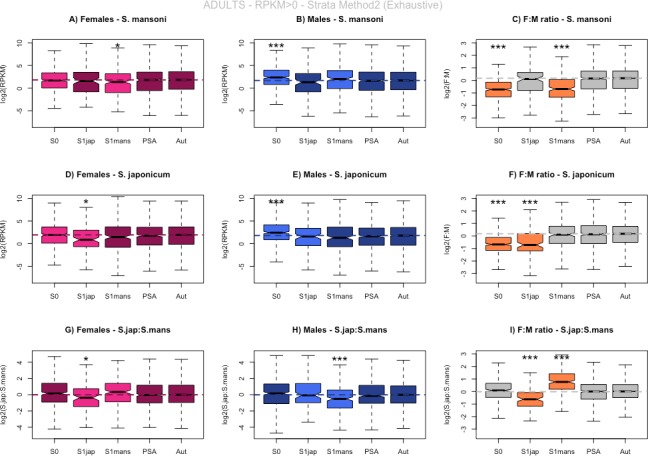
Adult expression patterns (RPKM>0, exhaustive strata) of genes located in the different strata of the Z (S0, S1man and S1jap), as well as pseudoautosomal and autosomal genes.The distribution of expression values is shown for (A) S. mansoni females, (B) S. mansoni males, (C) S. mansoni female:male, (D) S. japonicum females, (E) S. japonicum males, (F) S. japonicum female:male, (G) Female expression in S. japonicum divided by female expression in S. mansoni, (H) Male expression in S. japonicum divided by male expression in S. mansoni, (I) female:male ratio of expression in S. japonicum divided by female:male ratio of expression in S. mansoni. Asterisks represent levels of significance of comparisons to the control autosomal genes (*p-value<0.05, **p-value<0.001, ***p-value<0.0001). Genes were assigned to each Z-chromosome stratum based only on their coverage patterns; only genes with RPKM >0 were used.